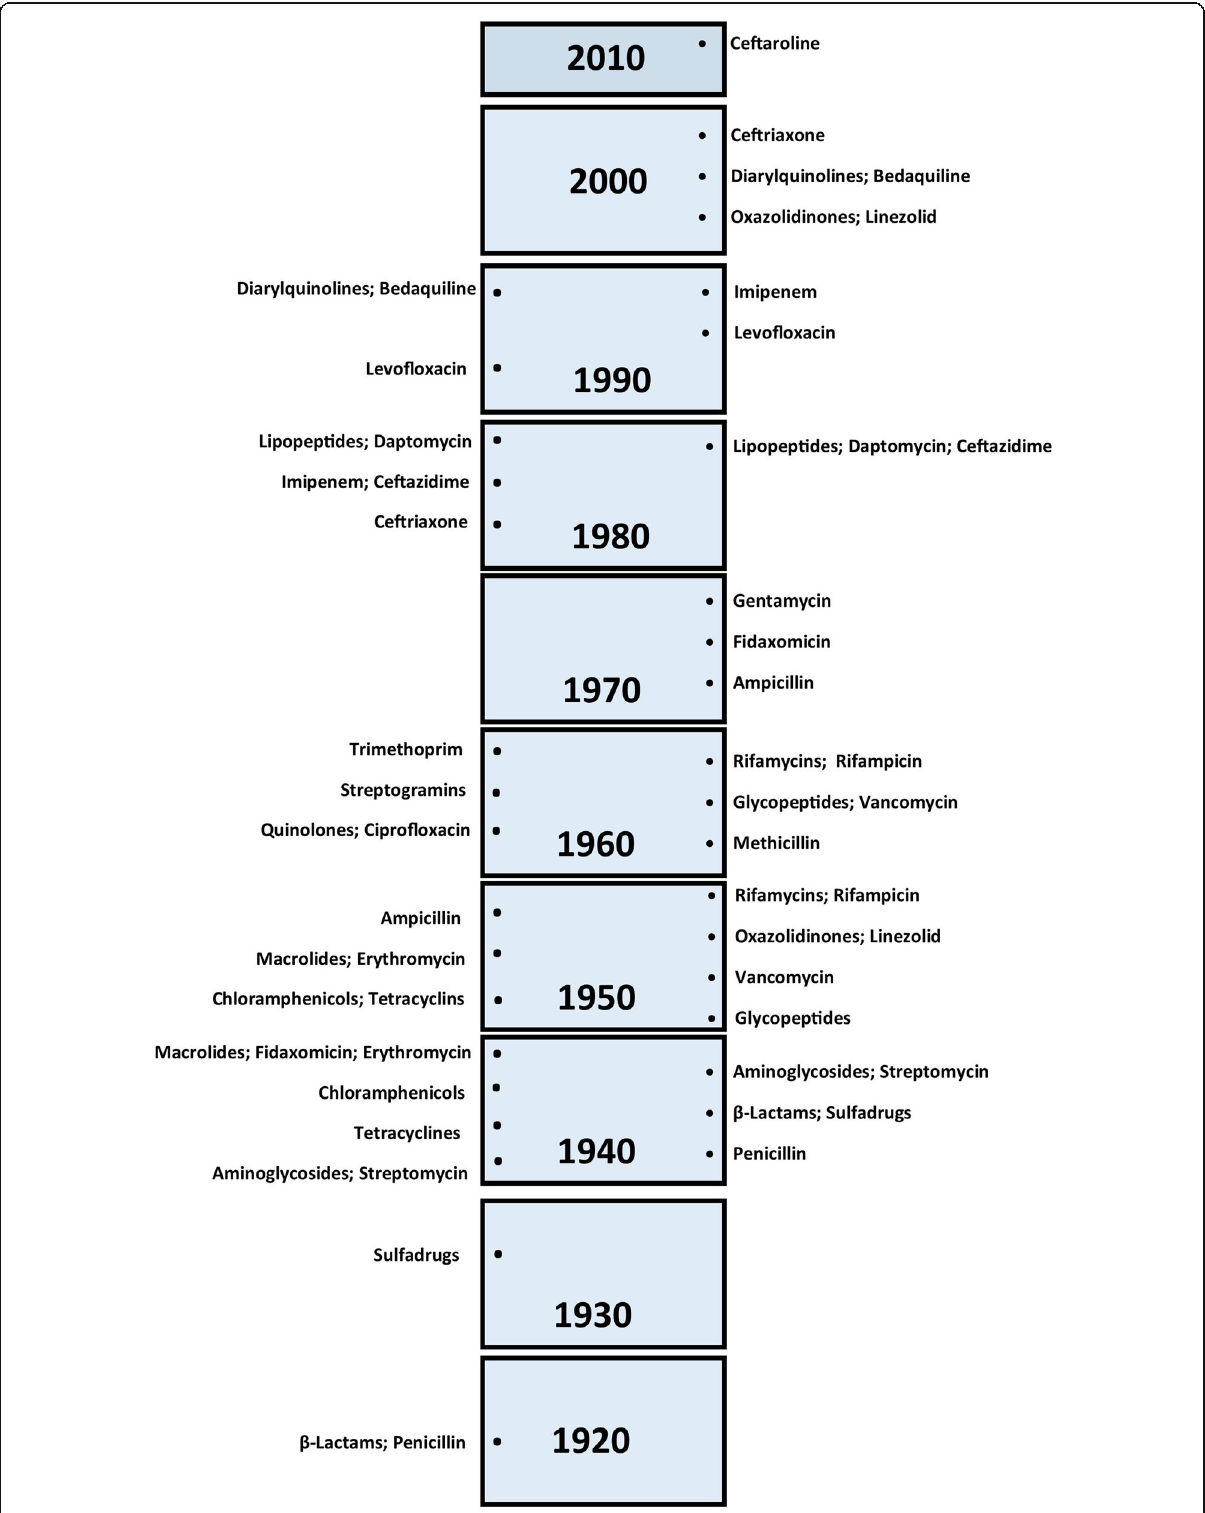
Fig. 6 Timeline of various antibiotics discovery (left) and resistance observed